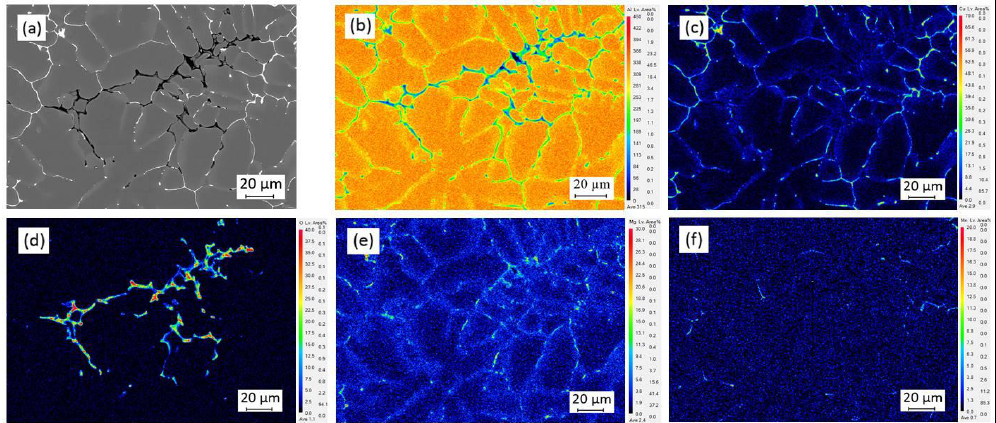
Figure 5. Elements map-scanning of 1 / 2 radius region of as-cast alloy cast by conventional DC casting ( a ) SEM micrograph of as-cast alloy, ( b ) Al; ( c ) Cu; ( d ) O; ( e ) Mg; ( f ) Mn.